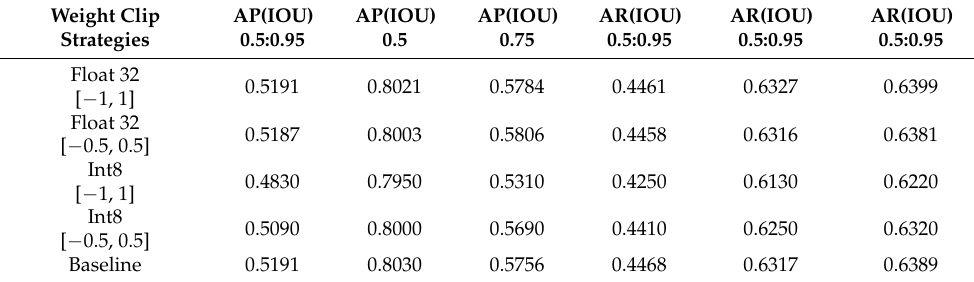
Table 5. Clipping and quantitative results of the two strategies.